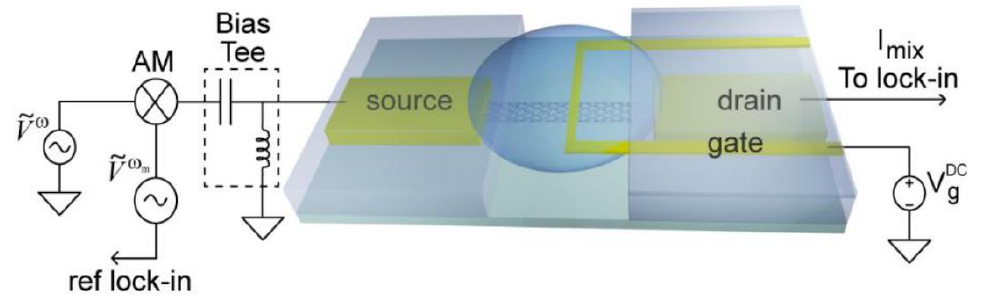
Figure 9. Nanoelectronic based heterodyne sensor. Reprinted with permission from [80], copyright 2012, American Chemical Society.